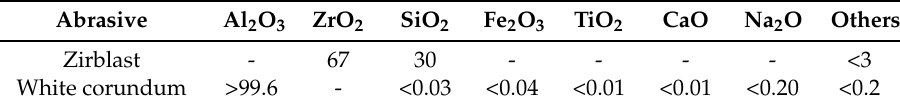
Table 2. Chemical composition of abrasives in wt. %.